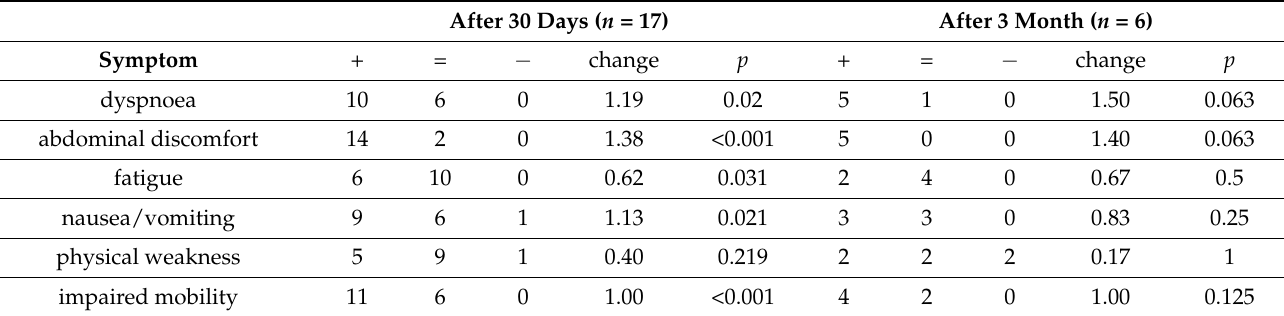
Table 2. Symptoms 30 days and 3 months after implantation of PleurX catheter compared to the time before implantation. “+” = decrease in symptoms in comparison to the time before PleurX insertion; “=“ = no change in symptoms; “ − “ = increase in symptoms; “change” = mean change of symptoms after PleurX insertion using a five point scale ( − 2 = significant deterioration; − 1 = slight deterioration; 0 = no change; 1 = slight improvement; 2 = significant